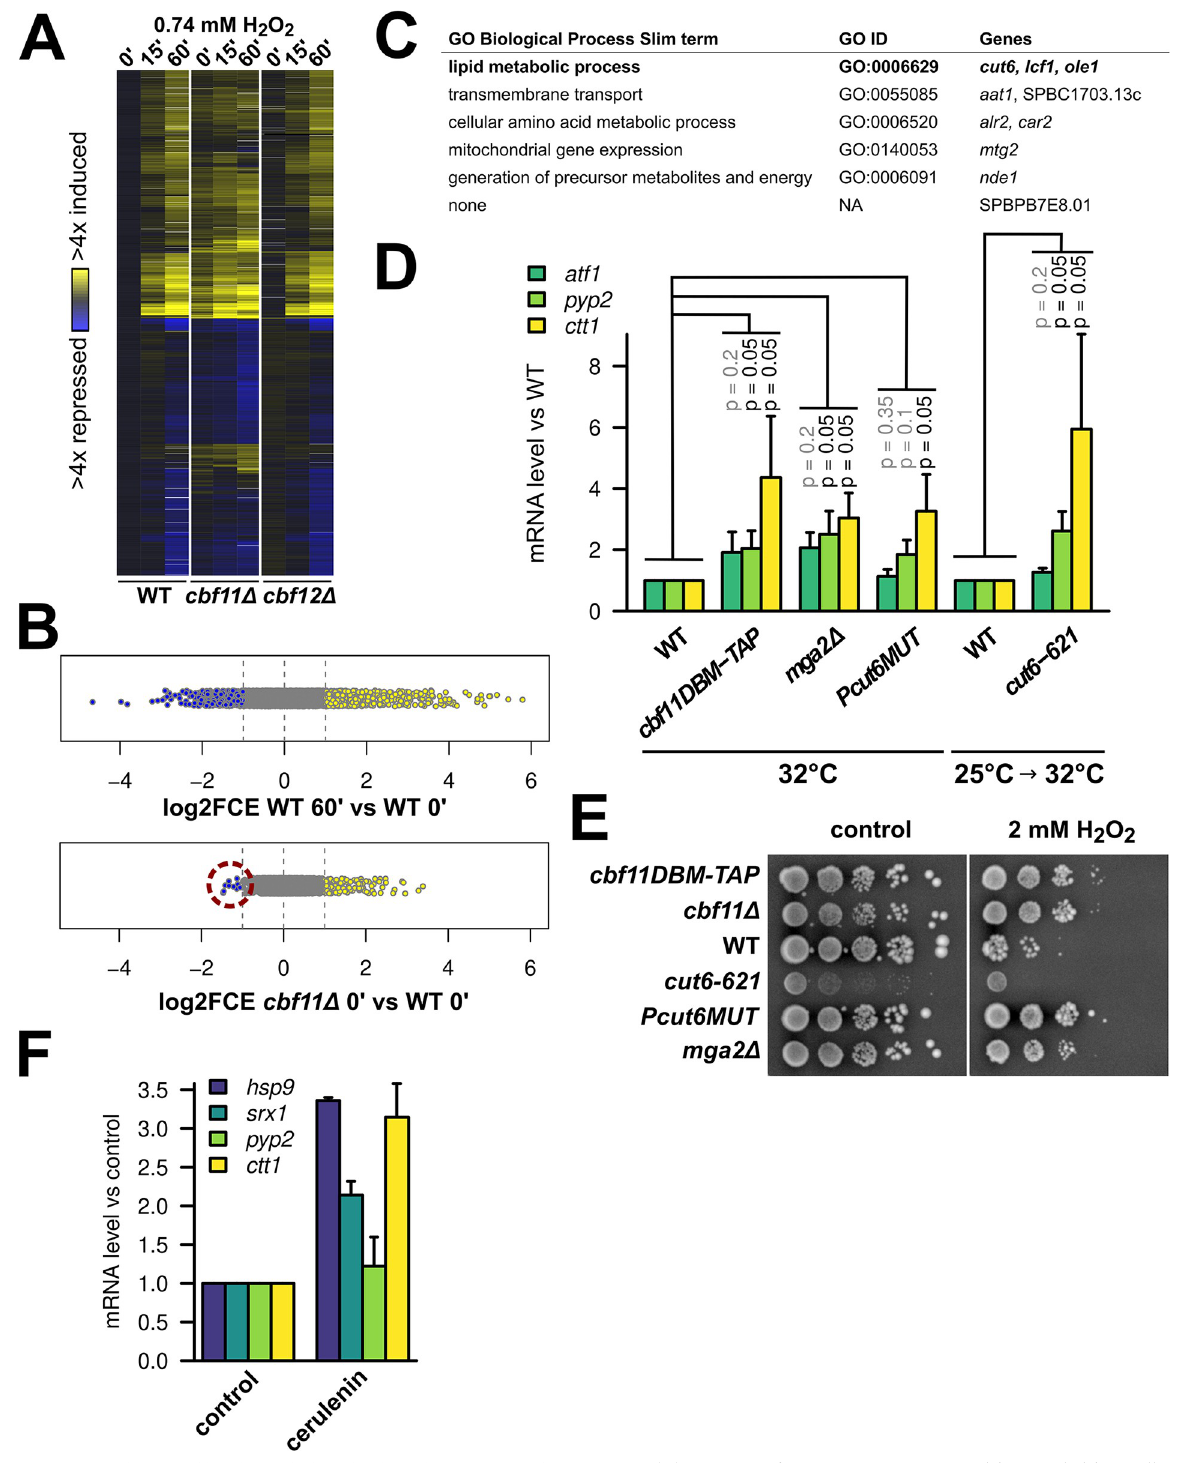
Fig 4. Perturbation of lipid metabolism leads to derepression of stress genes. (A) Heatmap of gene expression in WT, cbf11 Δ , and cbf12 Δ cells upon treatment with 0.74 mM H 2 O 2 in YES medium. Transcript levels were determined by a timecourse microarray analysis and normalized to untreated WT values. Only genes showing � 2-fold change in expression in at least one condition are shown. This experiment was performed once. (B) Distribution of all relative transcript levels in WT cells treated for 60 min with H 2 O 2 and untreated cbf11 Δ cells from the experiment in panel A. Values represent log2 of fold-changes in expression compared to untreated WT. Individual genes are shown as dots; blue and yellow